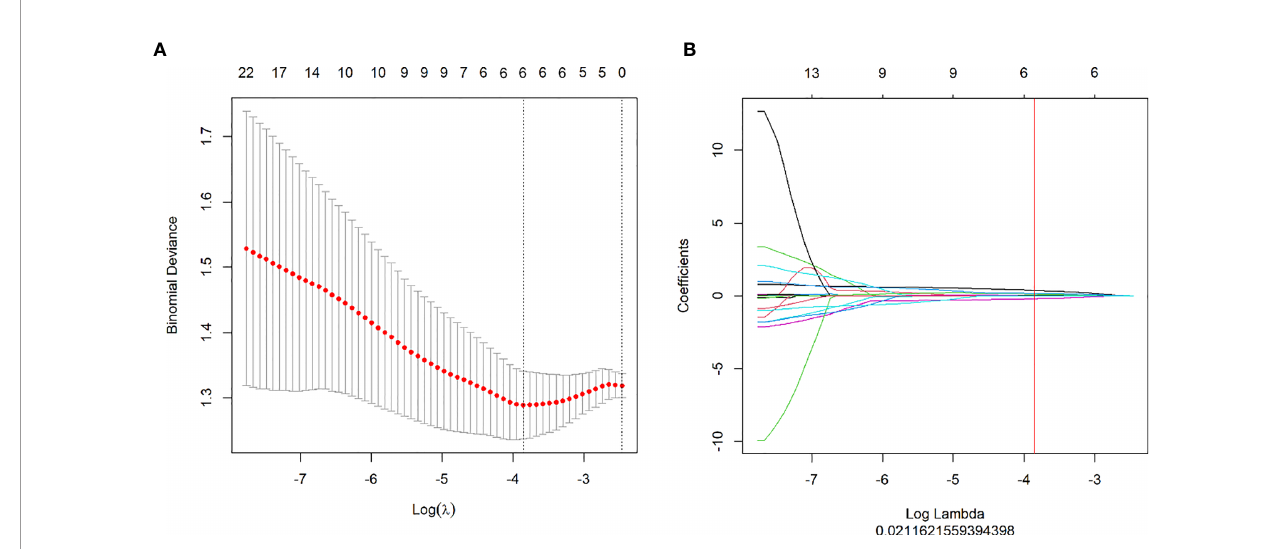
FIGURE 2 | Feature selection with the LASSO method. (A) The tuning parameter ( l ) changes in the LASSO model. The binomial deviance curve was generated with the log ( l ). The minimum criteria for fi ve-fold cross-validation were applied. The best l = 0.0212 was obtained at the minimal binomial deviance. (B) The LASSO coef fi cient pro fi le plot with different log ( l ) was shown. The vertical red line was the best l with 6 selected radiomic features.